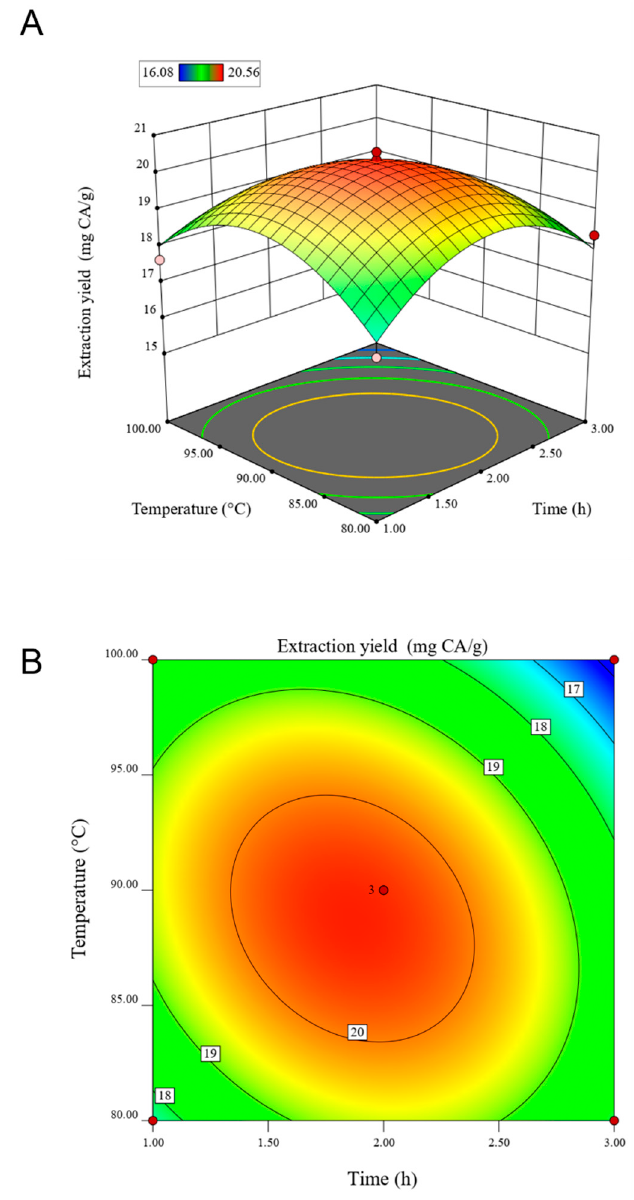
Figure 3. Response surface analysis based on time and temperature. ( A ) is the response surface graph and ( B ) is the corresponding contour graph.